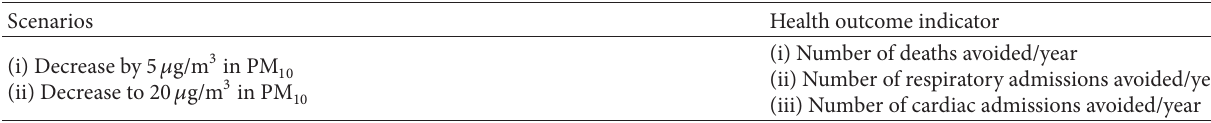
Table 2: Summary scenarios of PM 10 .